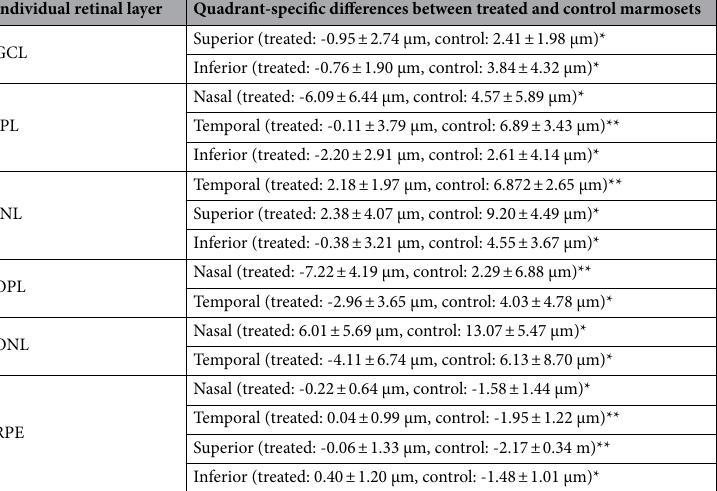
Individual retinal layer Quadrant-specific differences between treated and control